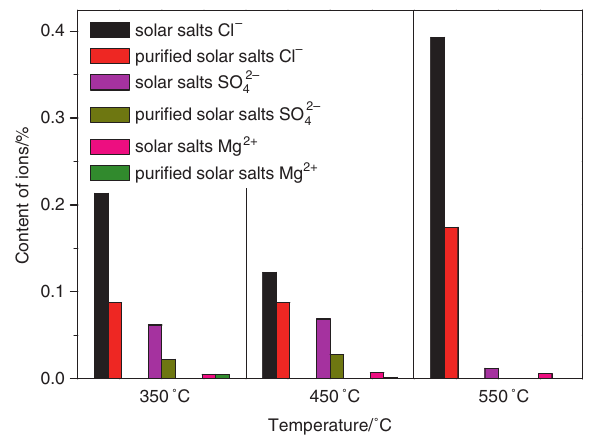
Figure 15: Upper limitation temperature of Solar Salt and purified Solar Salt after 27